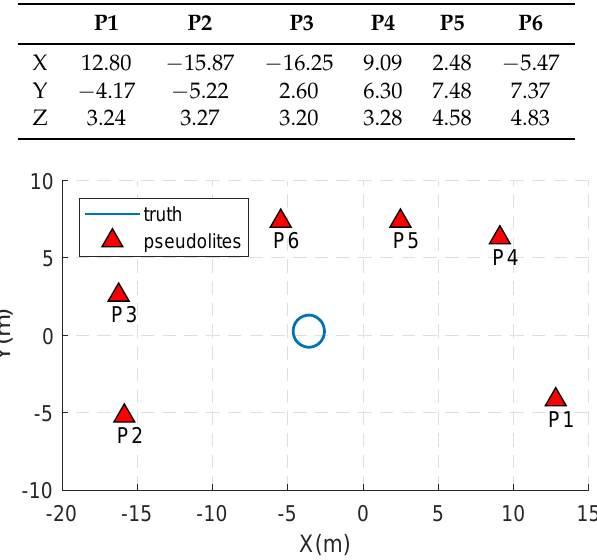
Table 1. The coordinates of six fixed pseudolites (unit: m).